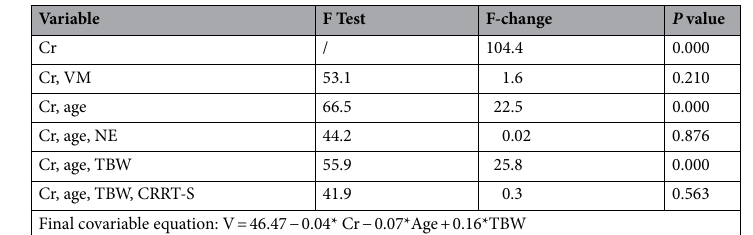
Table 4. Covariates for V screened by the stepwise method. Increases in the F value (F-change) represent the degree of influence of the addition of the corresponding covariate on V. ( P < 0.05 retained the corresponding covariate; P > 0.05 deleted the corresponding